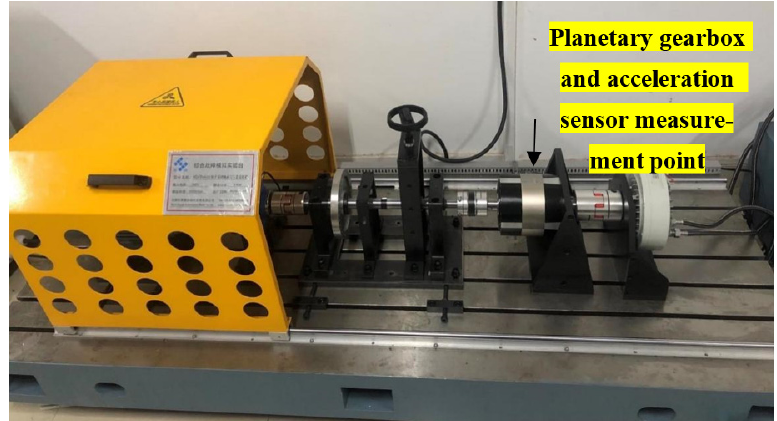
Figure 11. Integrated fault simulation test bench. Table 3. Gear parameters used in the